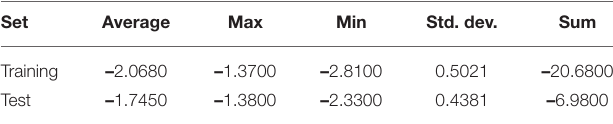
Table 2B | Unicolumn statistics of training and test sets for fungicidal activity against S. rolfsii .